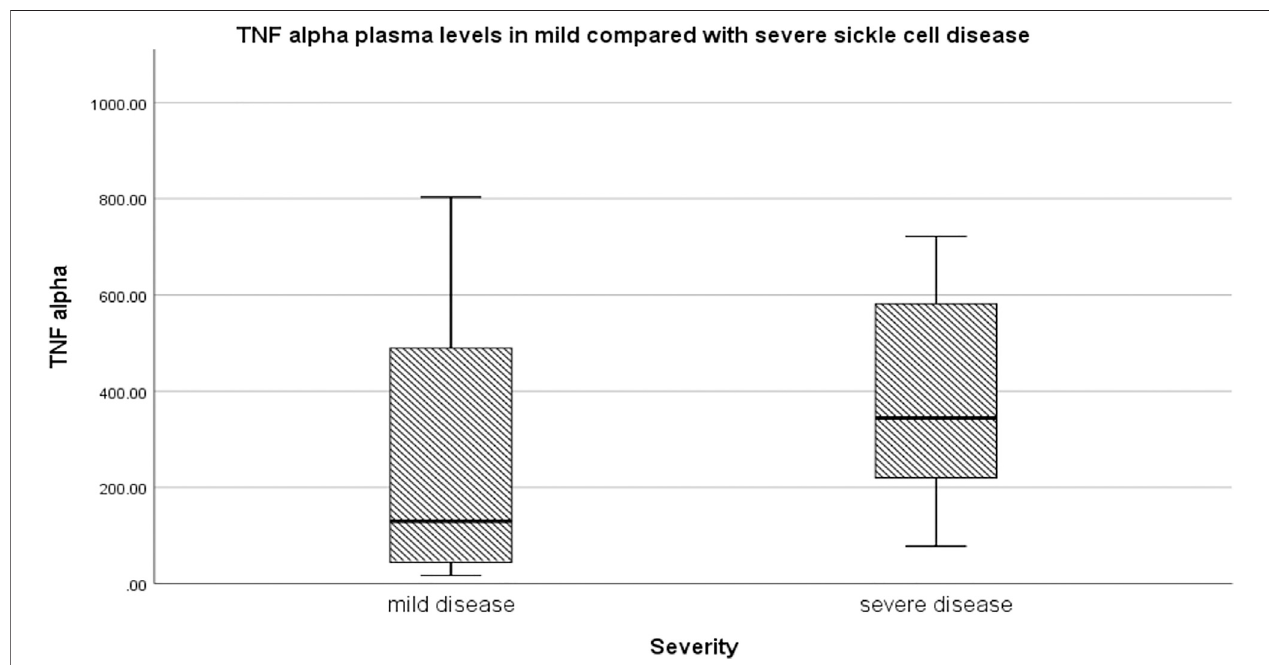
FIGURE2| Variationofplasmaconcentration(pg/ml)ofTNF-alphawithSCDseverity.ThethickhorizontallineineachboxrepresentsthemedianvalueofTNF- α for the disease severity group.